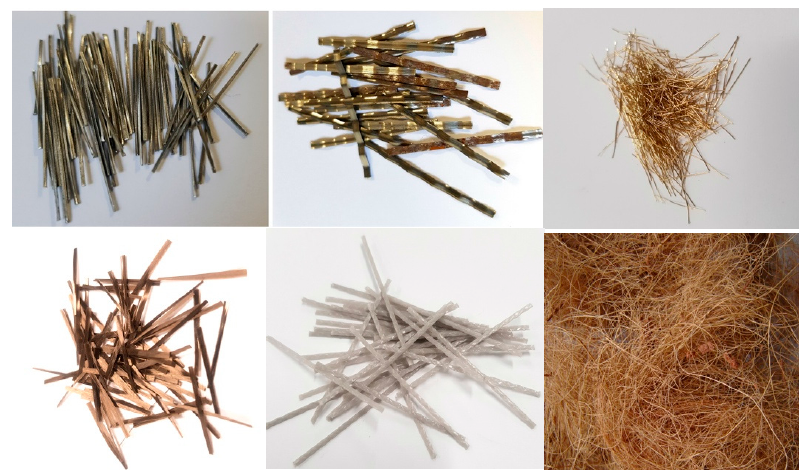
Figure 1. Samples of steel and copper fibres (top row), and basalt, plastic, and coconut fibres (bottom row).